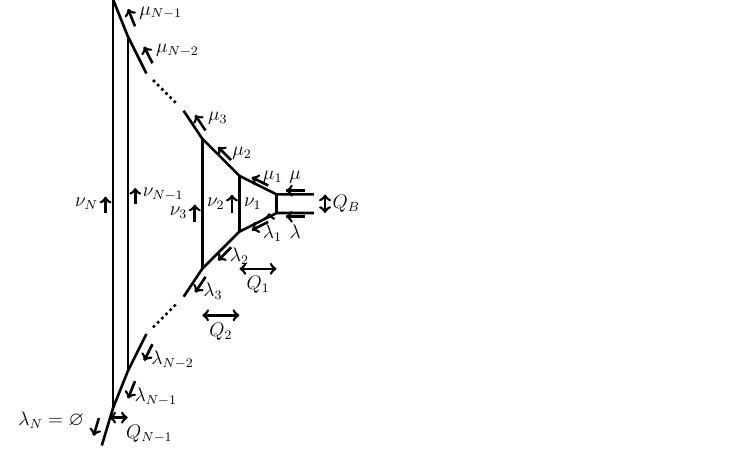
Figure 7 . The assignment of the Young diagrams, (cid:21); (cid:22); (cid:21) i ; (cid:22) i as well as the K(cid:127)ahler parameters Q B ; Q i for i = 1 ; ; N (cid:1) (cid:1) (cid:1) (cid:0)